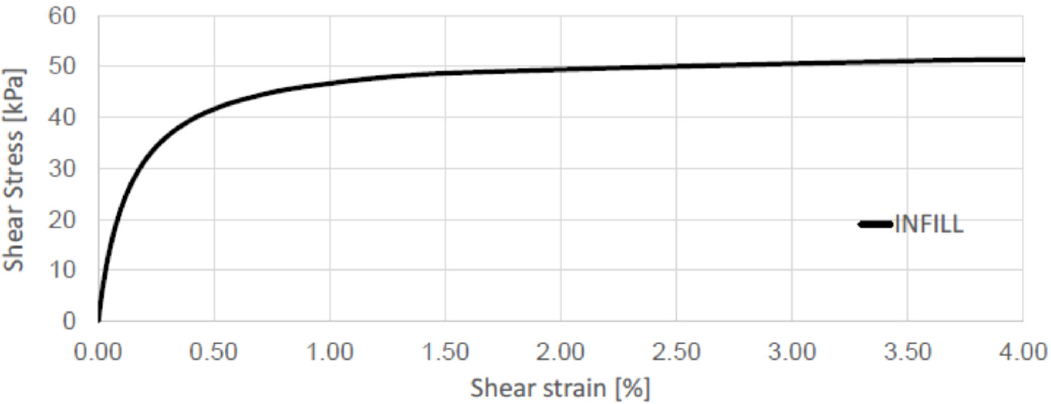
Figure 3. Backbone curve (infill soil).